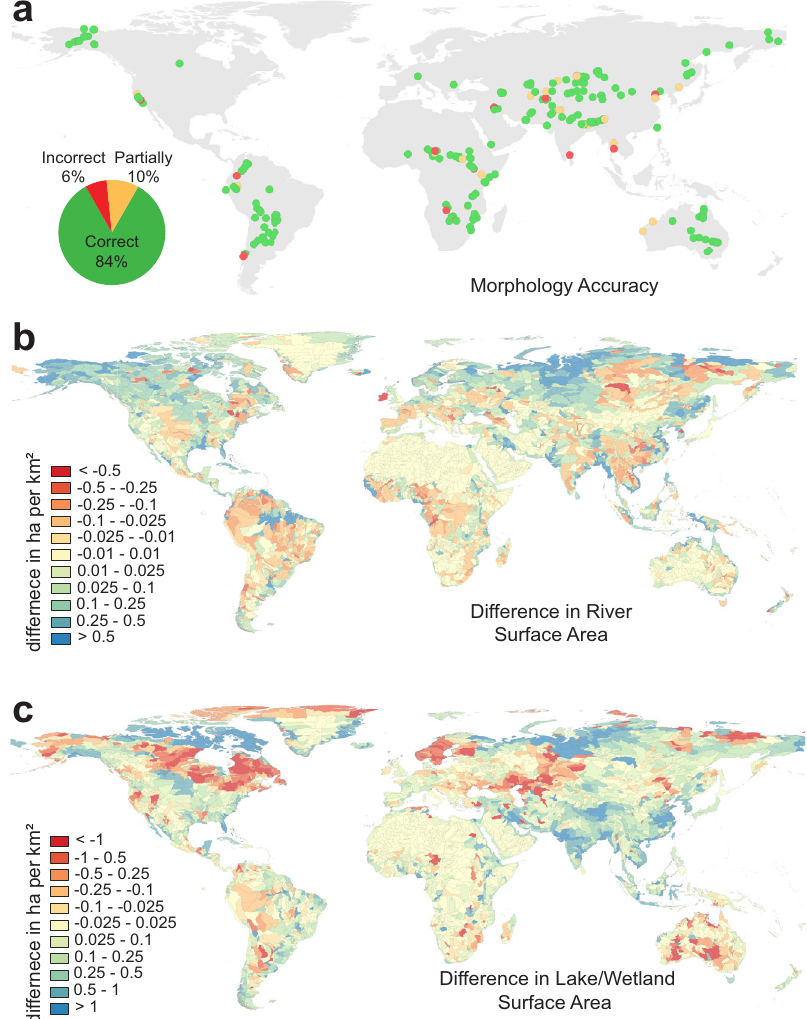
Fig.8| Examplerivermorphologypro fi le. a AccuracyoftheGlobalChannelBelt (GCB) morphology compared to manual classi fi cations by Hartley et al. 18 , ( b ) dif- ference in river surface area per km 2 within each sub-catchment between the GCB